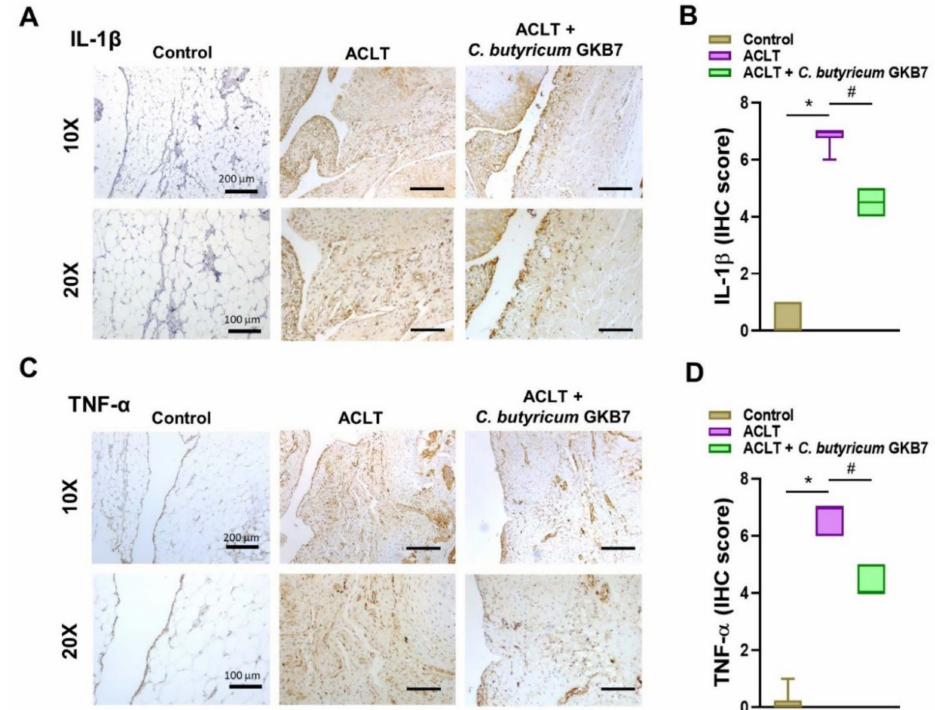
Figure 6. Oral C. butyricum GKB7 downregulates IL-1 β and TNF- α in OA synovium. ( A , B ) Immuno- histochemistry analysis and scoring of levels of IL-1 β and ( C , D ) TNF- α expression in right knee joint synovium. * p < 0.05 ACLT-only vs. controls; # p < 0.05 ACLT-only vs. ACLT + C. butyricum